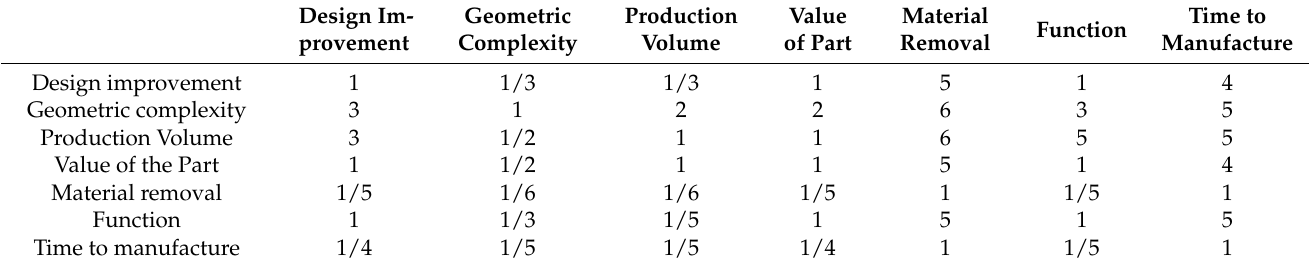
Table 6. Pairwise comparison matrix.